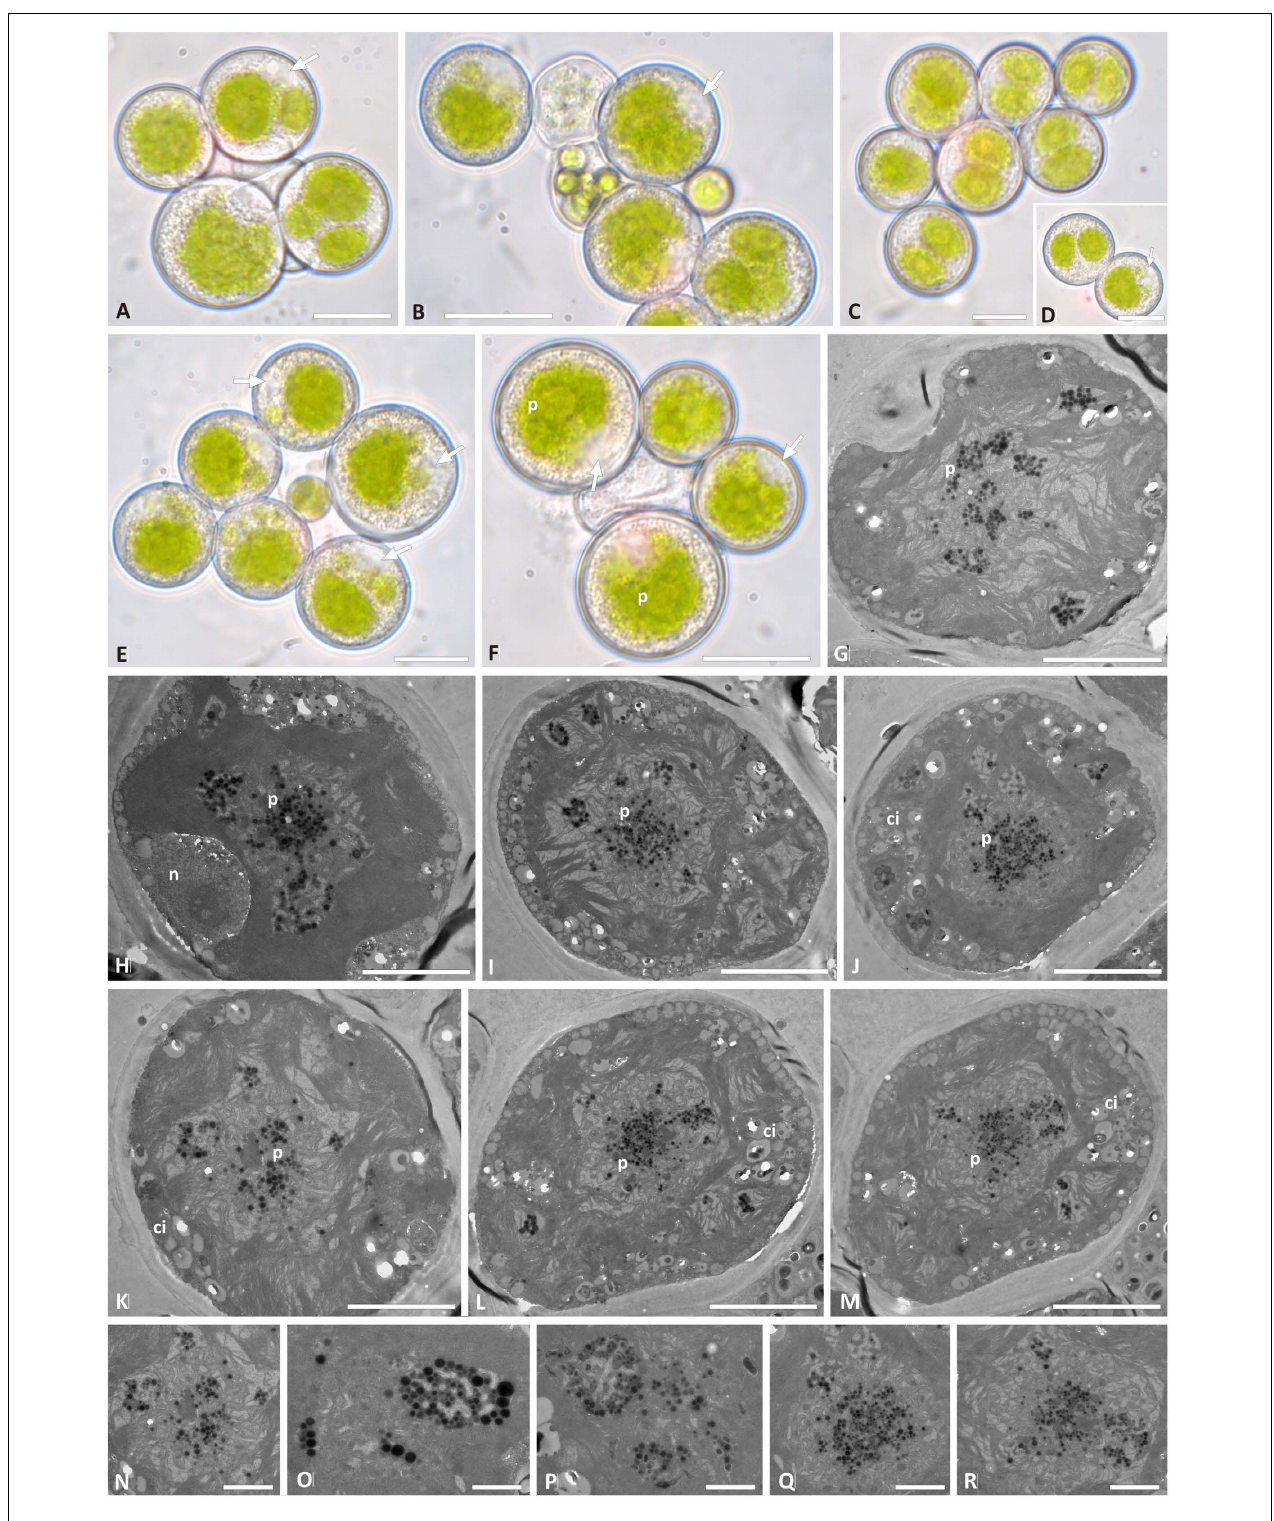
FIGURE 6 | Morphology and pyrenoid ultrastructure of the Trebouxia vagua “A04” axenically cultured strain L2943 ( Supplementary Table 2 ). (A–F) Algal cells observed by light microscopy; arrows indicate the lobes of the chloroplast (central green body) and the nucleus. (G–R) TEM microphotographs of algal cells: (N–R) detail of pyrenoid ultrastructure. The letters indicate cytoplasmic inclusion (Ci), nucleus (n), and pyrenoid (p). Scale bars: (A–F) 10 µ m; (G–M) 5 µ m; (N–R) 2 µ m.